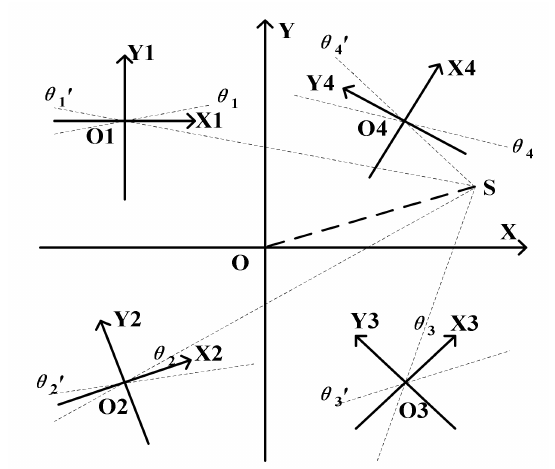
Figure 6. The positioning principle of array hydrophone.